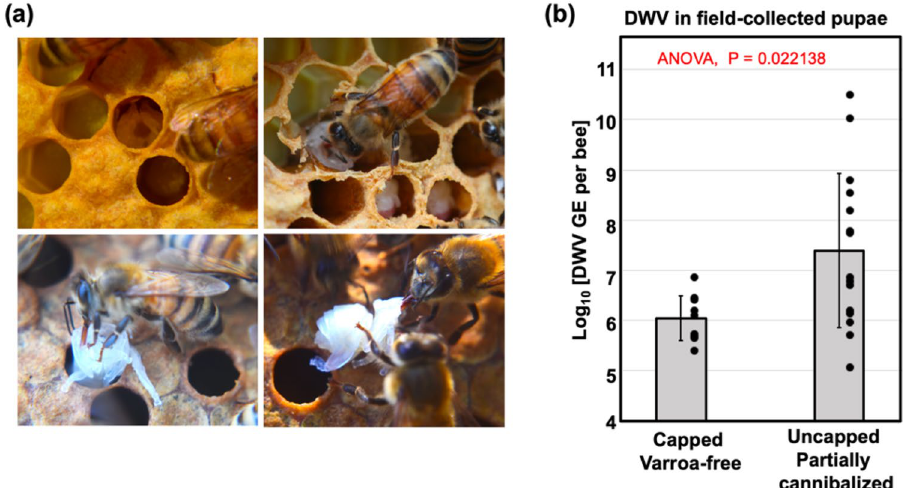
Figure 1. ( a ) Honey bee pupal cannibalization by worker bees. Top images: partially cannibalized pupae observed immediately after hive opening; bottom images: partially cannibalized pupae were pulled out from the cells and cannibalization continued after five minutes. ( b ) Average DWV RNA loads in field-collected capped and in partially cannibalized uncapped honeybee pupae, with error bars indicating standard deviation. DWV copy number in individual pupae are indicated by black